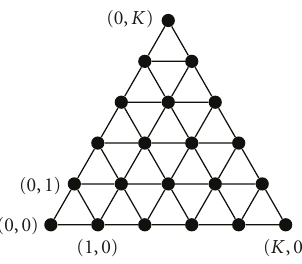
Figure 3: Nodes at a subset of the hexagonal lattice with the connectivity induced by a transmission range r = 1. The size of the network is controlled by K , with K = 5 in this